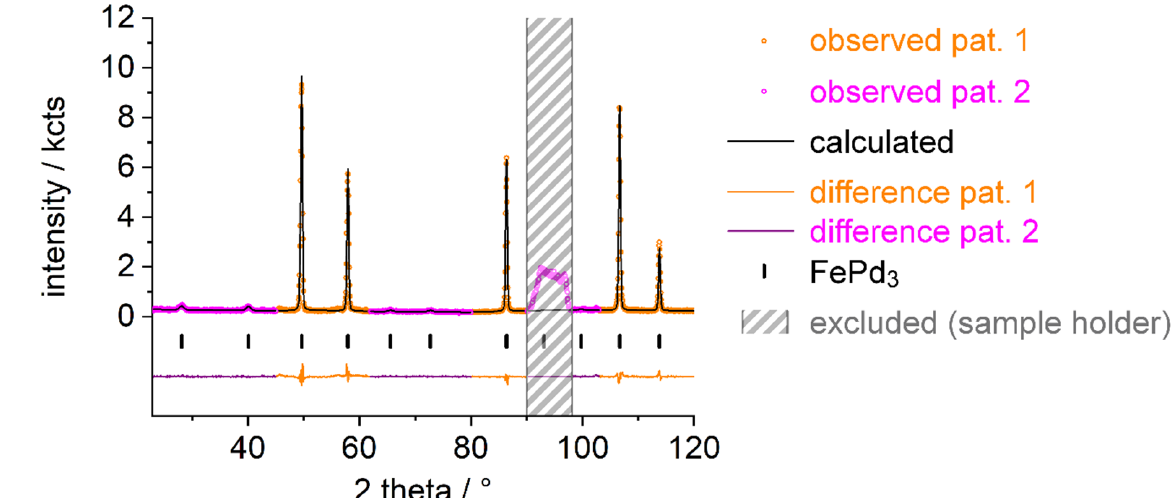
Figure A18. Rietveld refinement of the crystal structure of FePd 3 D 0.063(9) (for details, see sixth row in Tables A8 and A9) based on neutron powder diffraction data (NUMOR 131772 [21], λ = 186.80(2) pm, D20 ILL, Grenoble) in a single-crystal sapphire cell at 424(3) K and 8.15(1) MPa deuterium pressure using FullProf [24].